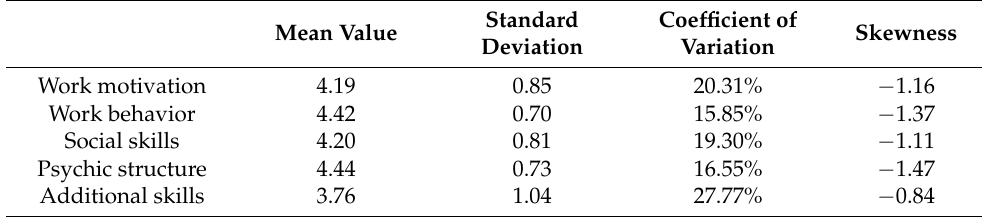
Table 3. Overall descriptive statistics of the questionnaire by scales. Mean